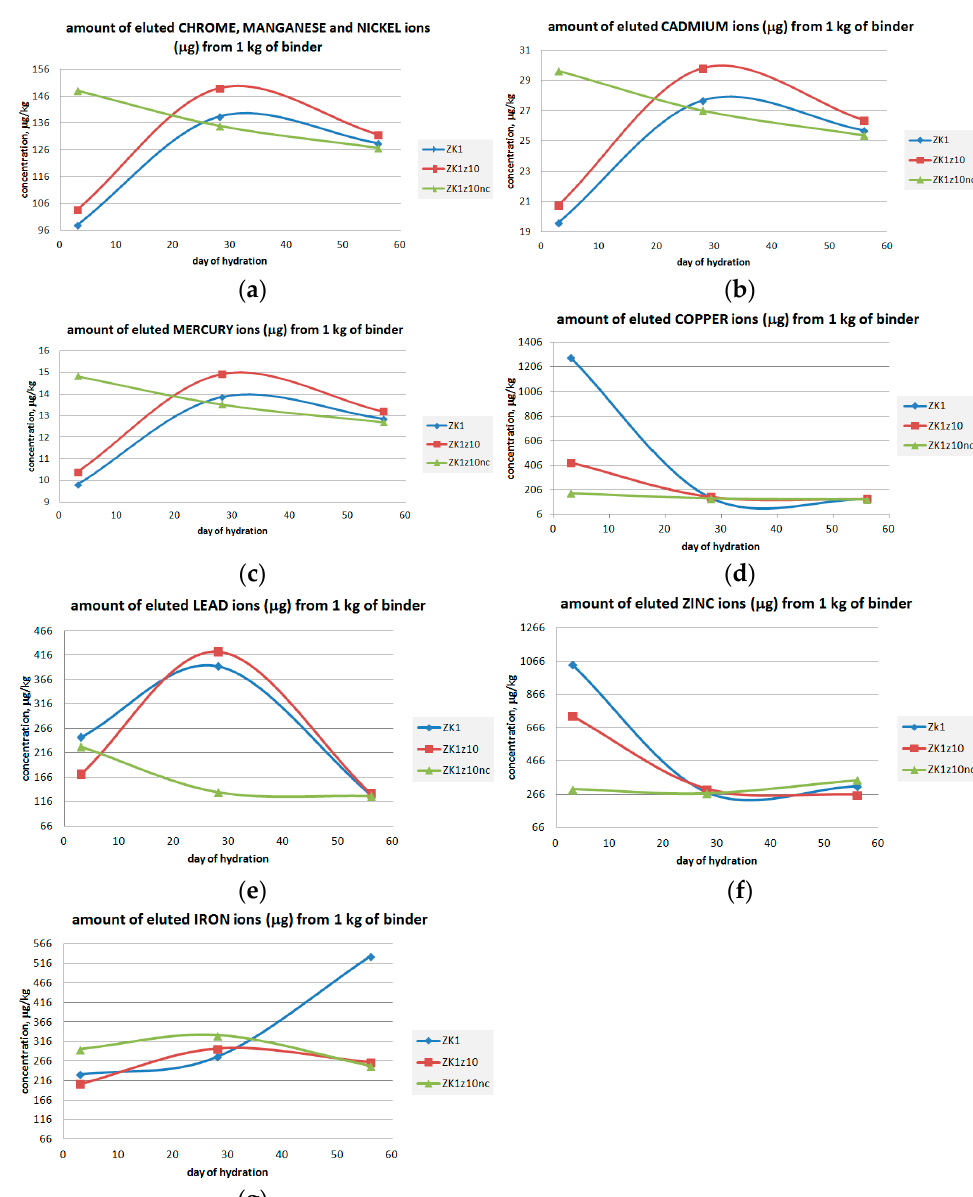
Figure 13. The concentrations of metals washed out from crushed mortars converted to the content in the binder. Amount of eluted: ( a ) Cr, Mn, Ni; ( b ) Cd: ( c ) Hg; ( d ) Cu; ( e ) Pb; ( f ) Zn; ( g ) Fe ions. Chromium, manganese, nickel, cadmium, mercury and lead bound very well in the ZK1 and ZK1z10 matrices already in the 3rd day of hydration. After 4 weeks, the immo-